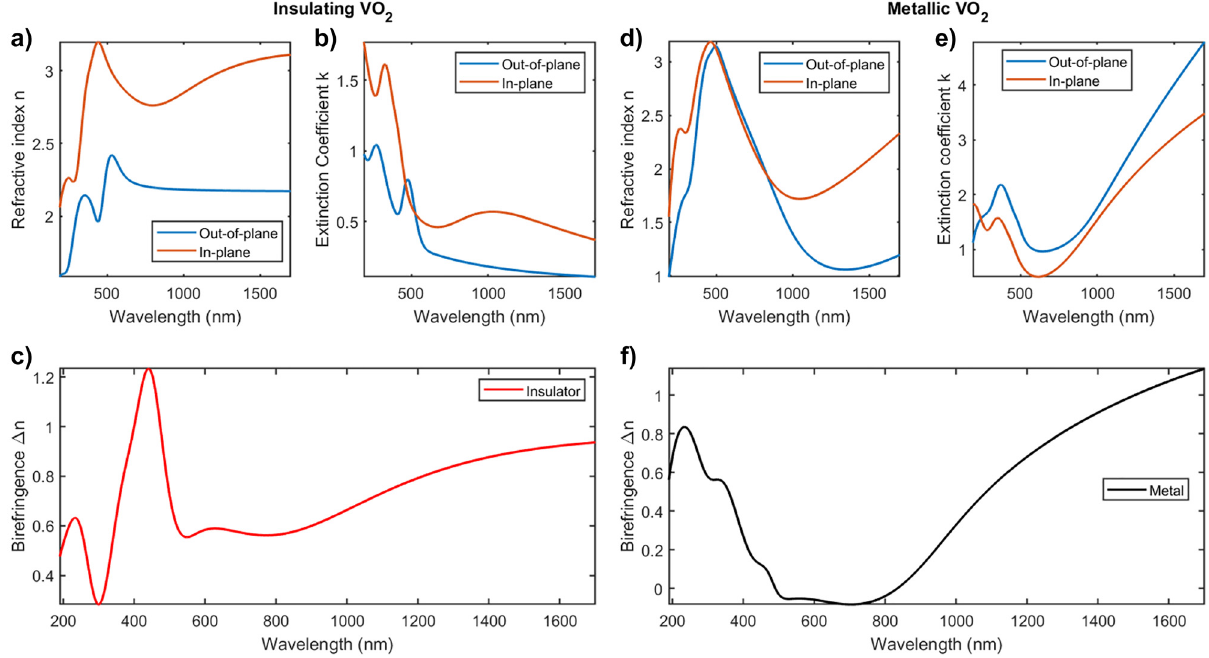
thin films, extracted from spectroscopic ellipsometry in the range 190–1700 nm. Figure 3: Optical properties of epitaxial VO 2 In (a and b) and (d and e), both the in-plane (red lines) and out-of-plane (blue lines) complex refractive indices are plotted for the VO (b and c). (c and f) report the calculated birefringence values Δ n for both VO monoclinic insulating state (a and b) and for rutile metallic VO 2 states, revealing a very large optical anisotropy throughout the measured wavelength